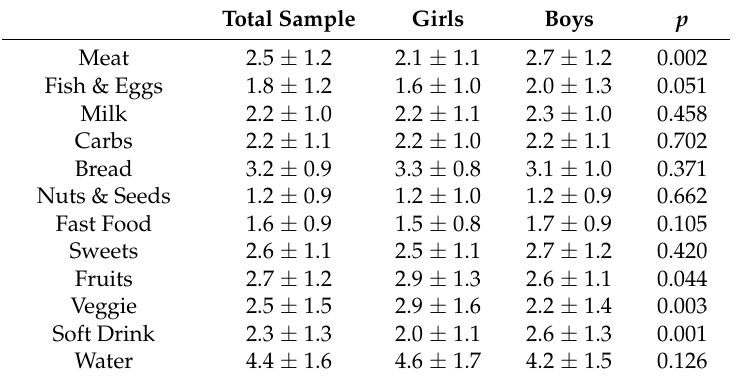
Table 2. Frequency of consumption of food groups (days/week). Values are Means ±